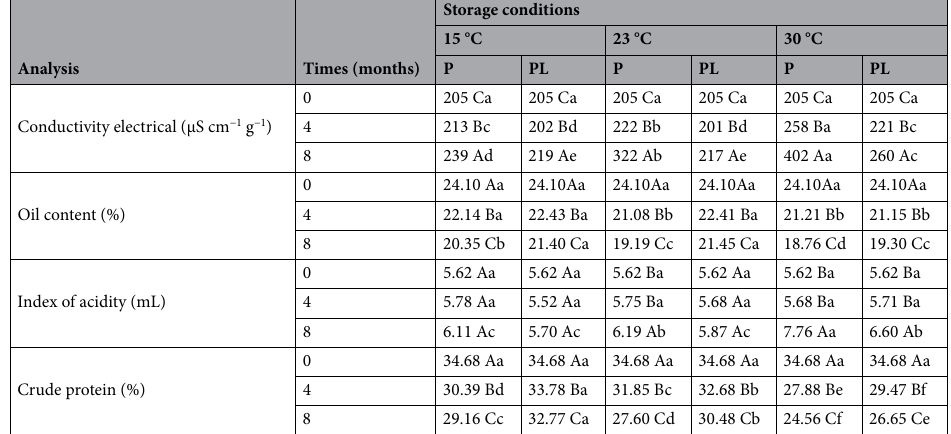
Table 7. Quality of soybeans harvest at 23% (d.b.) moisture content subjected to drying at 80, 100 and 120 °C, stored in different environments and packaging for eight months. Means followed by the capital letter in the column for each time of storage and lower lines for each temperature of storage. do not differ at 1 and 5% probability. PL—polyethylene plastic bag. P—paper